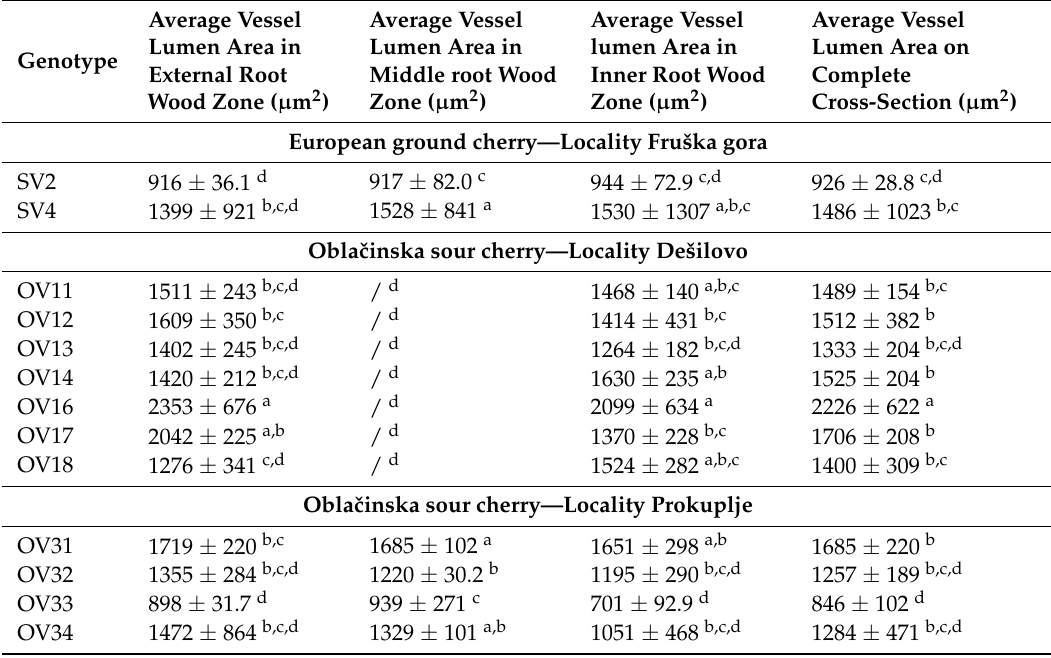
Table 3. Average vessel size of different secondary root zones and complete cross-sectional